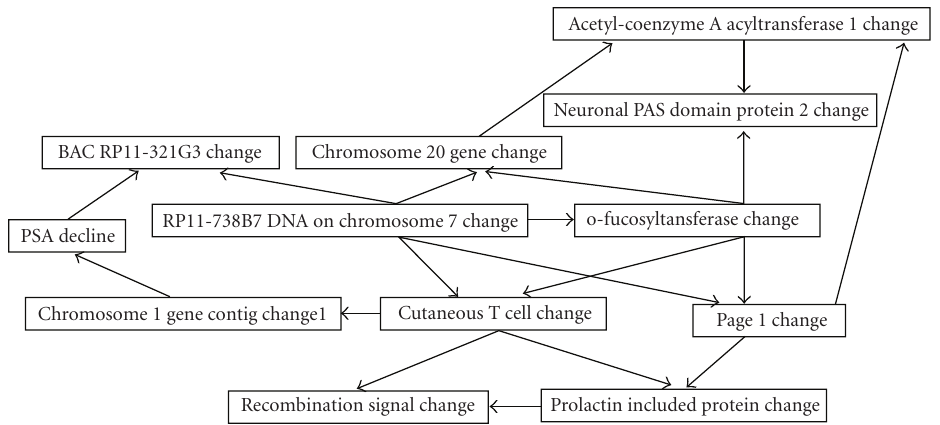
Figure 4: Structure of Bayesian Belief Network representing selected subset of biomarkers. The structure of the network represents the hierarchy of conditional dependence between features, hence we can identify that the two first degree associates of clinical response are change in IgG responses to BACRP11-321G3 and chromosome 1 gene contig 1. Further, because IgG response to BAC RP11-321G3 is a shared child between PSA decline and IgG response to RP11-738B7 DNA on chromosome 7, IgG response to RP11-738B7 DNA on chromosome 7 still influences the estimate of PSA decline even when IgG response to BAC RP11-321G3 is